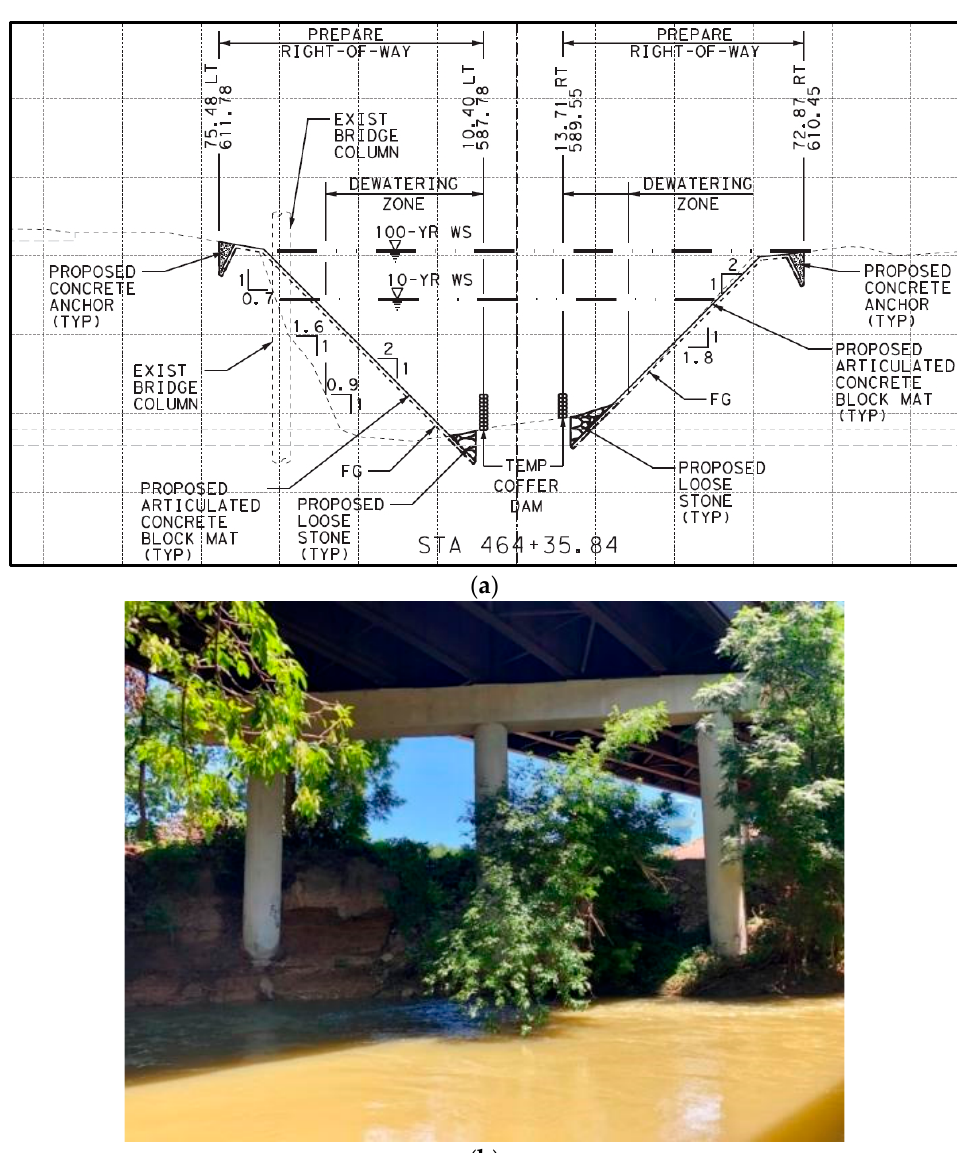
Figure 3. Existing and proposed channel bank configuration ( a ) and existing bank conditions ( b ).